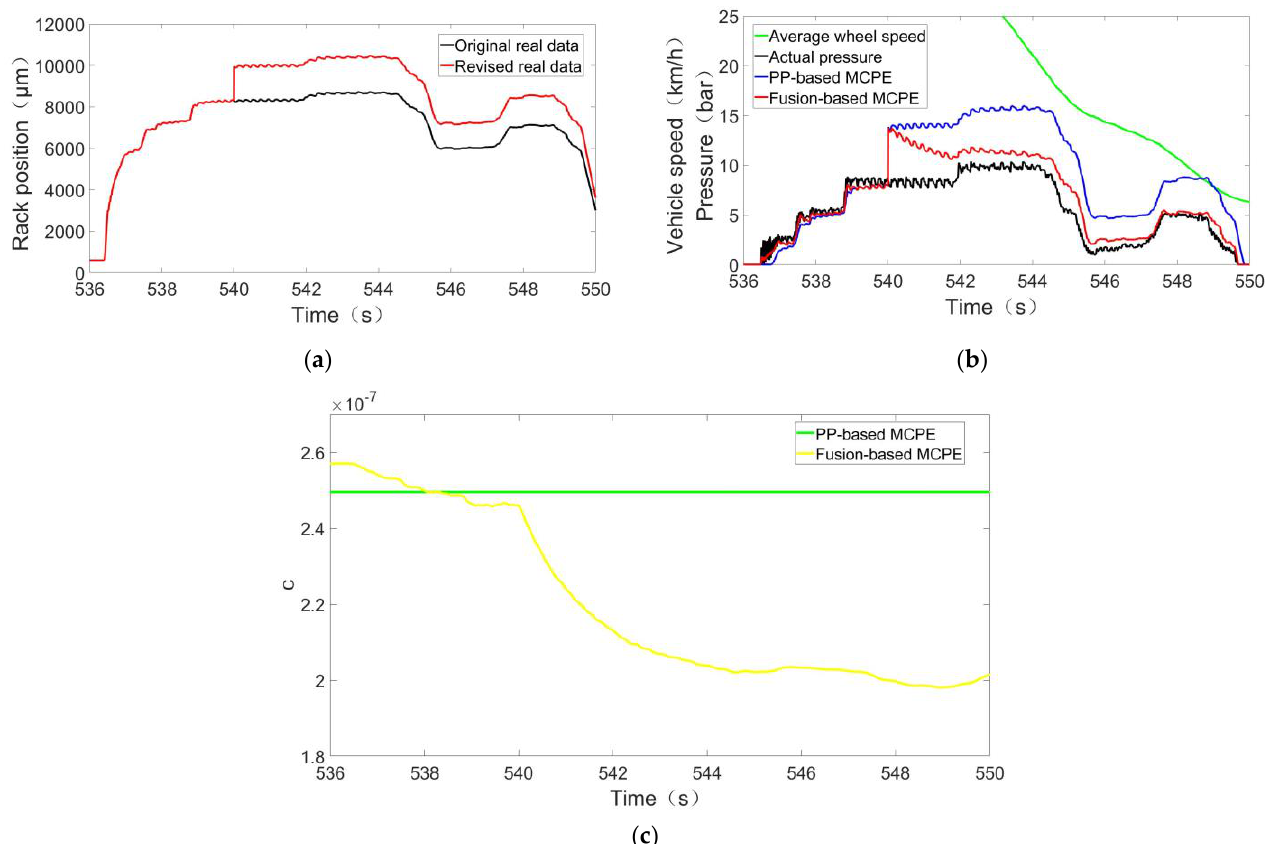
Figure 9. Simulation results of the fusion-based MCPE and the PP-based MCPE when the brake pad wears: ( a ) represents the rack position. ( b ) represents the actual and the estimated brake pressure. ( c ) represents the coefficient c in the pressure-position model.